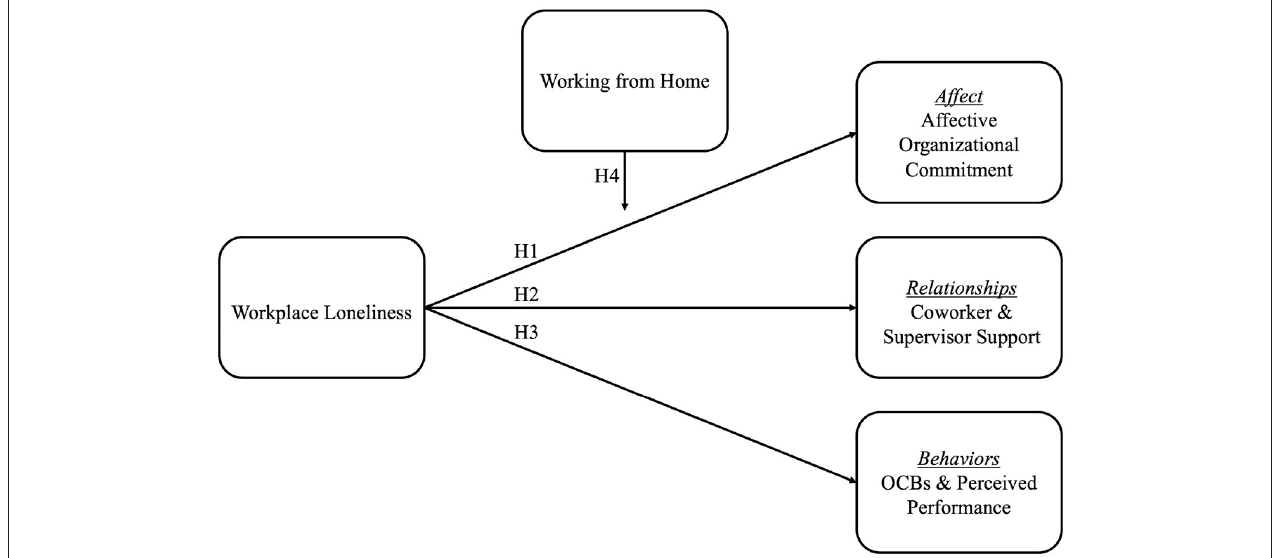
FIGURE 1 | Theoretical